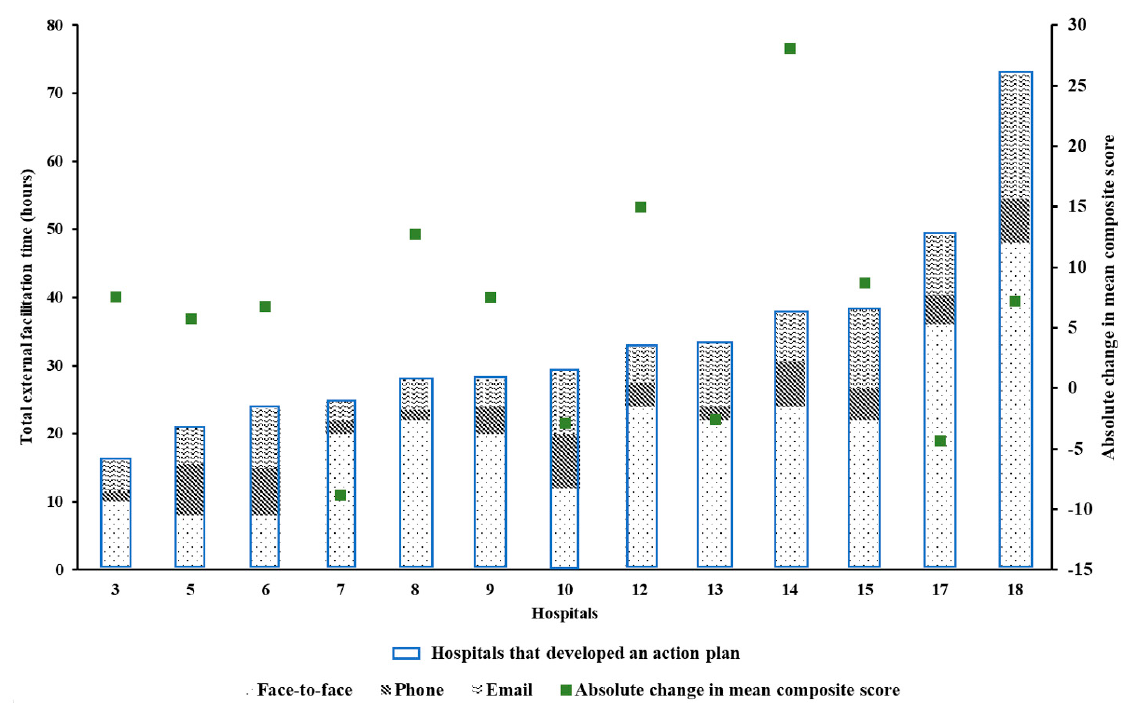
Figure 5. Absolute change in composite score from acute stroke processes of care nominated by hospitals in their action plans vs. support provided by external facilitators to the respective hospitals during the multicomponent quality improvement program—Enhanced StrokeLink period is displayed in hours.